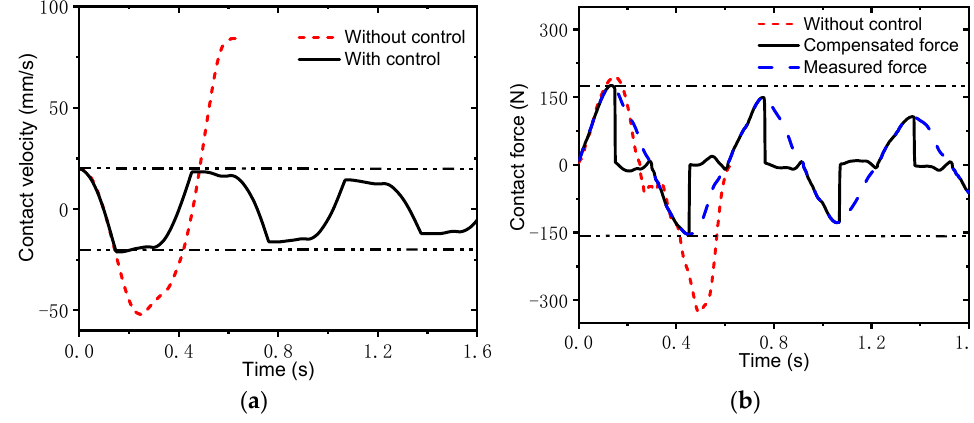
Figure 15. Contact velocities and forces in experiments ( f =2.2 Hz). ( a ) Velocities. ( b ) Forces.